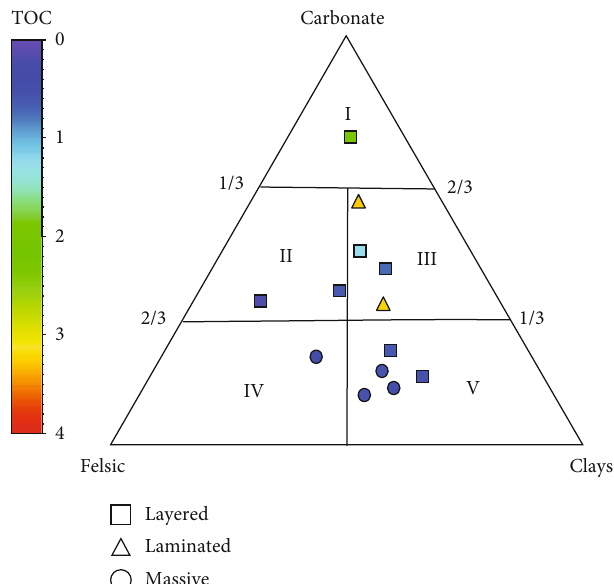
Figure 3: Ternary diagram of mineral compositions and structures of 13 fi ne-grained Shahejie Shale samples in the upper part of the fourth member, Dongying Sag: I, limestone facies; II, siliceous marlstone facies; III, clayey marlstone facies; IV, siliceous mudstone; V, clayey mudstone facies. Table 1: Basic properties of shale core samples used for pore structure studies. Sample